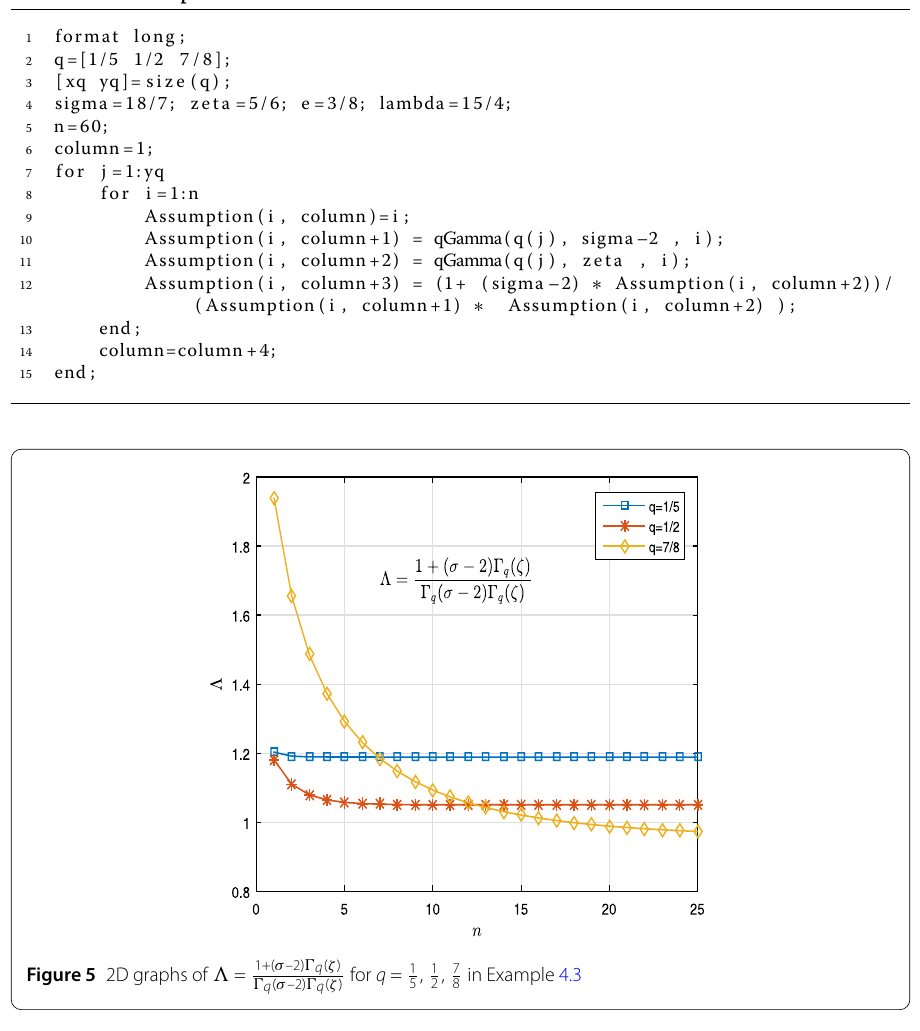
q ( σ –2) (cid:12) q ( ζ )